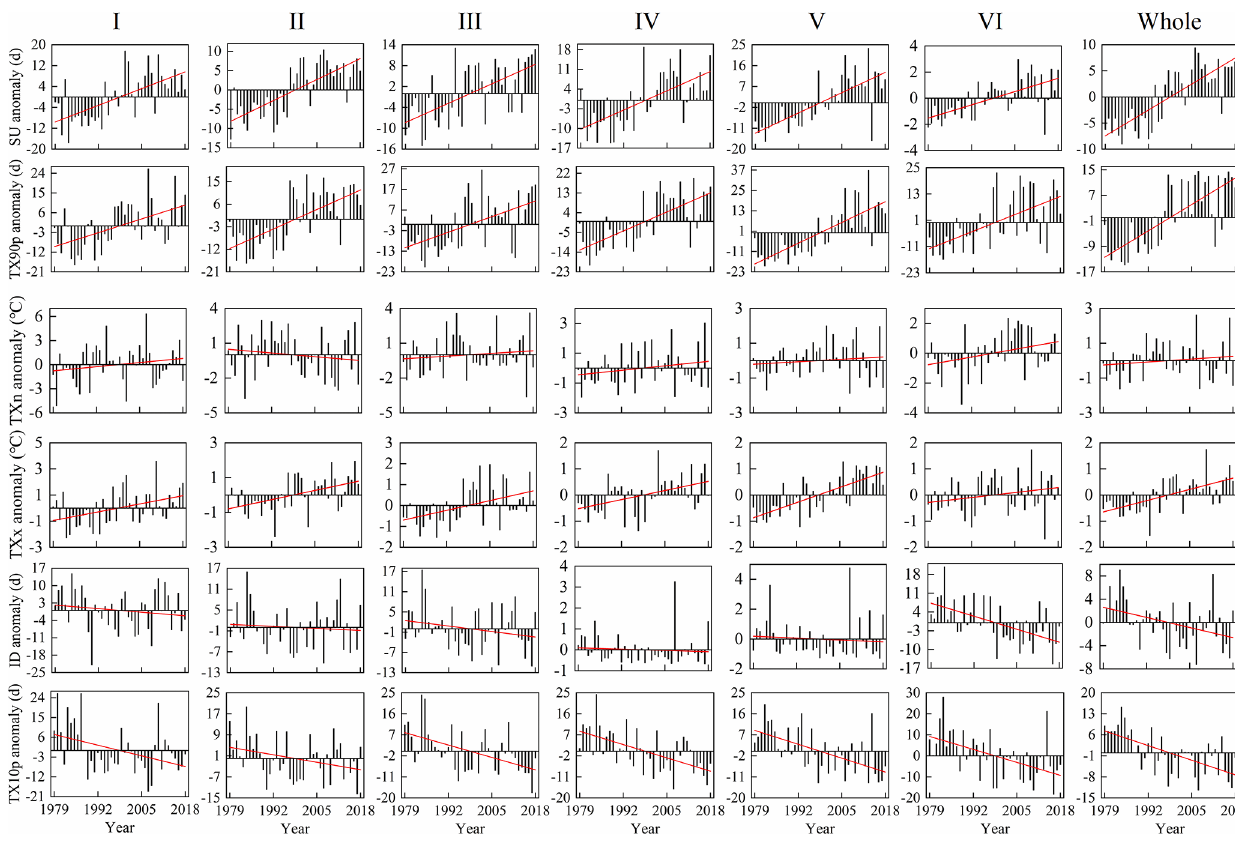
Figure 13. Inter-annual trend of extreme temperature indices anomalies in different regions of China during 1979–2018.